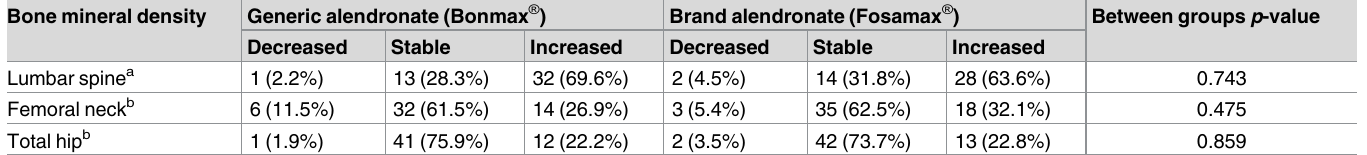
Table 3. Number and percentage of patients with stable, increased, or decreasedbone mineral densities after one year of treatment with generic or brand alendronate.